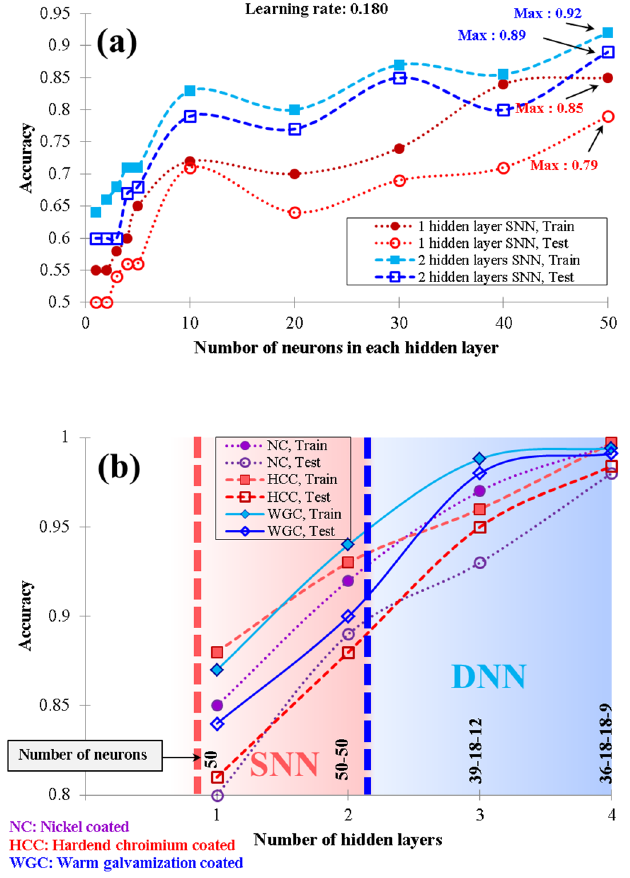
Figure 4. ( a ) Performance of the developed SNNs with considering the number of neurons in each layer and ( b ) Comparison of the accuracy of developed SNNs and DNNs.